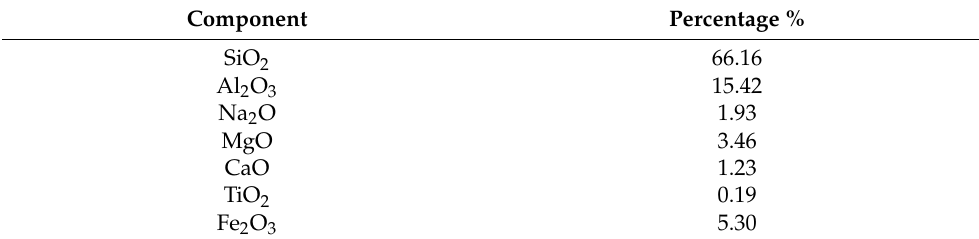
Table 1. Composition of